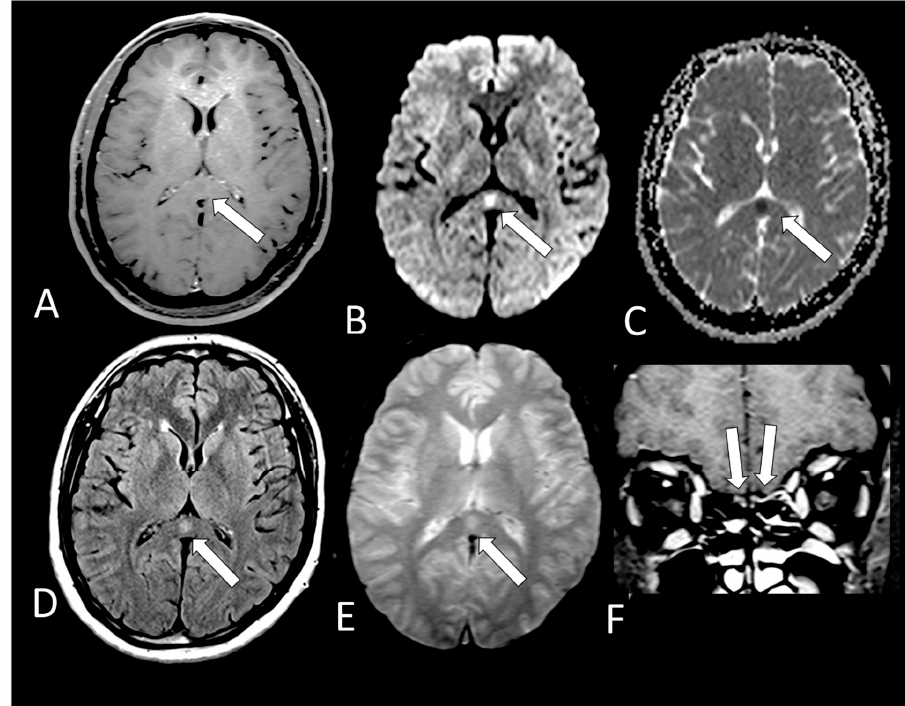
Figure 6. Case 18—On MRI, there is a small round lesion on the splenium of the corpus callosum which could represent a cytotoxic lesion due to a cytokine storm and differential diagnosis is with small acute infarct. It is hypointense on T1 ( A , arrow) with restricted diffusion, being hyperintense on DWI ( B , arrow) and hypointense on ADC ‐ Map ( C , arrow). This lesion is also hyperintense on FLAIR ( D , arrow) and T2* ( E , arrow) without microbleeding. The olfactory bulbs are hyperintense on coronal post contrast fat suppressedT1WI ( F , arrows) in comparison to the gray matter of the frontal lobes, which can represent enhancement, but we cannot exclude microbleeding.